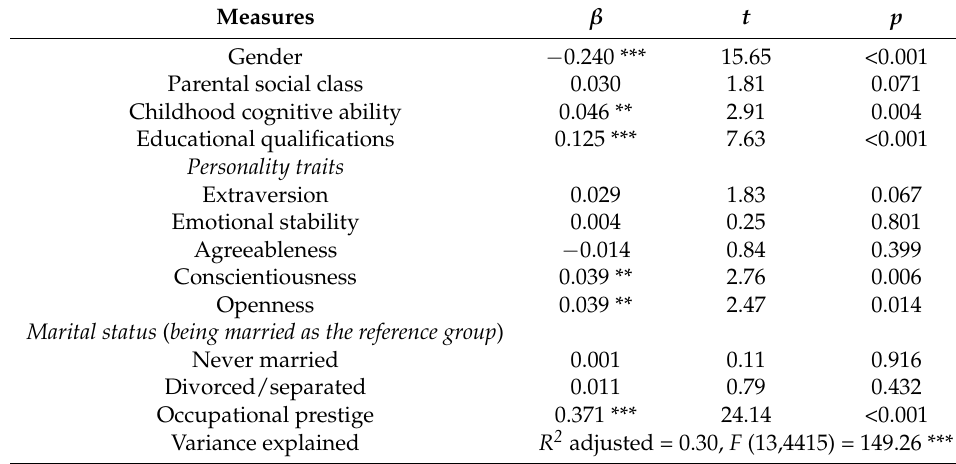
Table 2. Predicting adult earning ability from childhood and adulthood psychological and socio-demographic